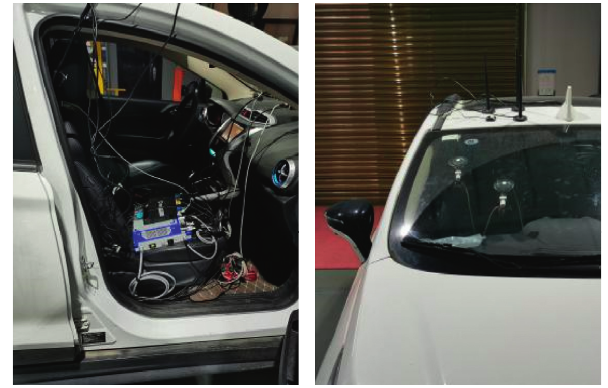
Figure 4: Layout of vehicle-mounted units and antenna